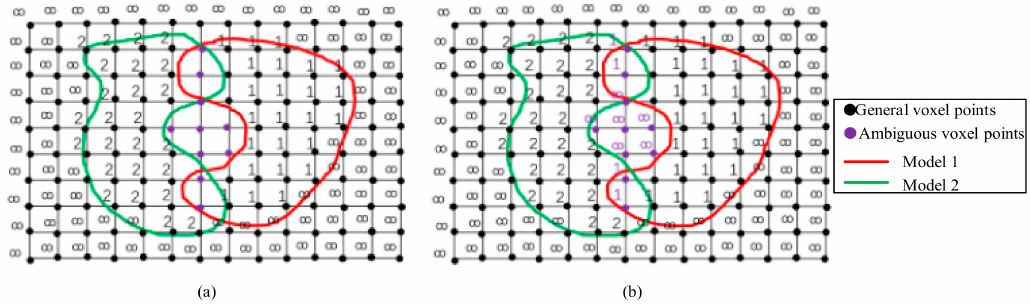
Figure 4. Set the labels of voxel points. ( a ) Labels of the general voxel points. ( b ) Labels of the ambiguous voxel points. As shown in Figure 4a, the label of the red model is 1, and its interpolation function is f 1 , and the labels of all voxel points inside the red model are set to 1; the setting method of the labels for the green model is similar to the red. The labels of the voxel points in the exterior area are set to ∞ . Generally speaking, the labels of the voxel points correspond to both the labels of the geological bodies and the subscripts of the interpolation